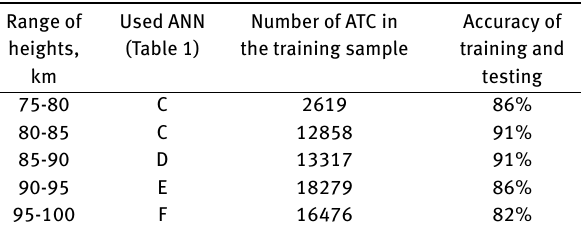
Table 2. The results of the classification of ATC with heights separa- tion.